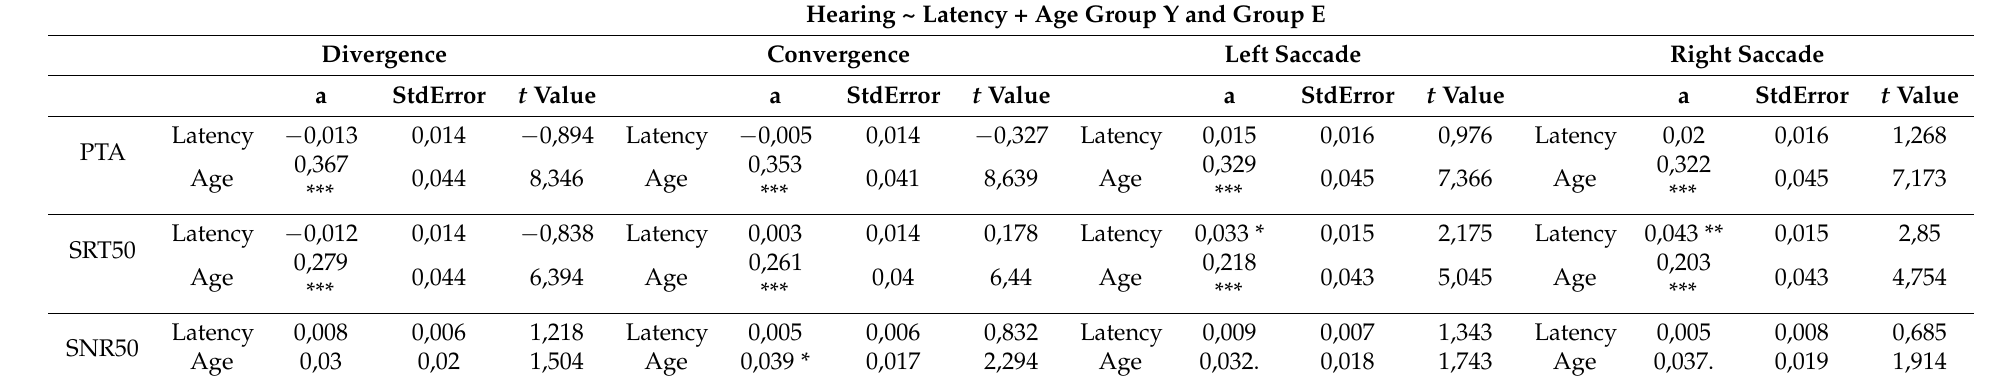
Table 2. Multiple regressions: hearing results as a function of eye movement latency and